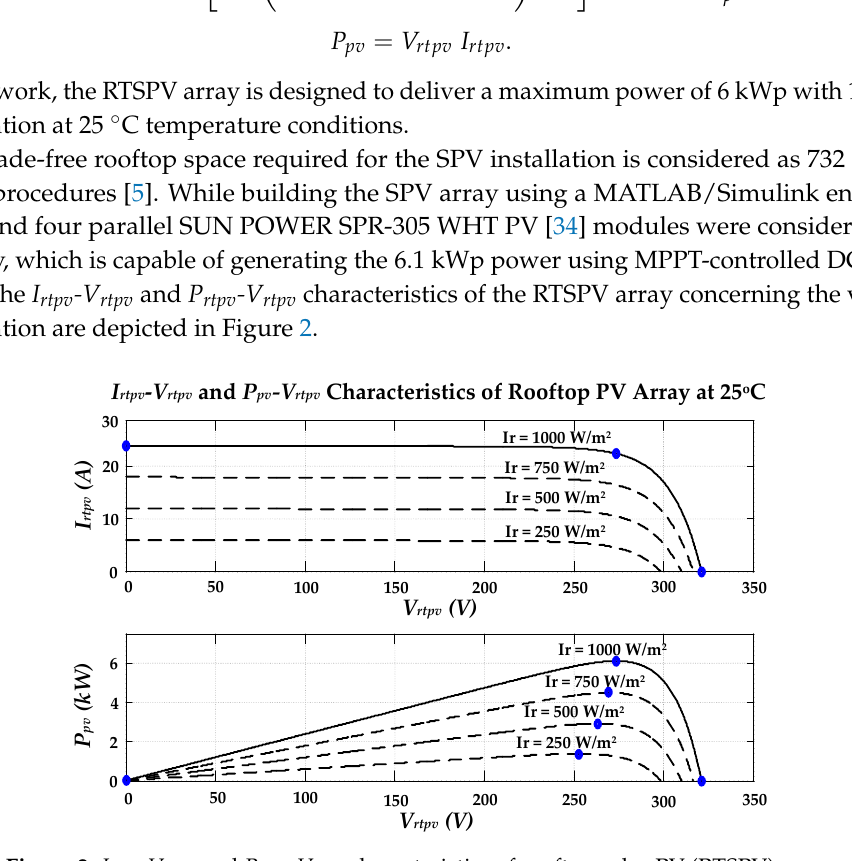
Figure 2. I rtpv - V rtpv and P rtpv - V rtpv characteristics of rooftop solar-PV (RTSPV) array.